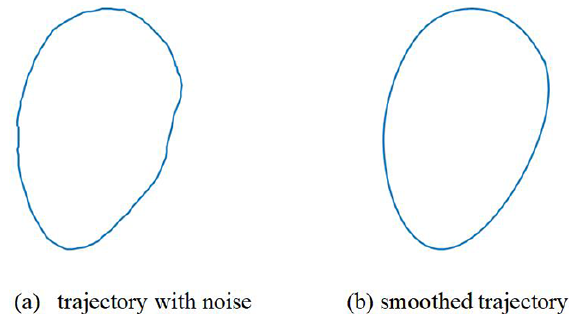
Figure 4. The trajectories: (a) original trajectory with noise and (b) smoothed